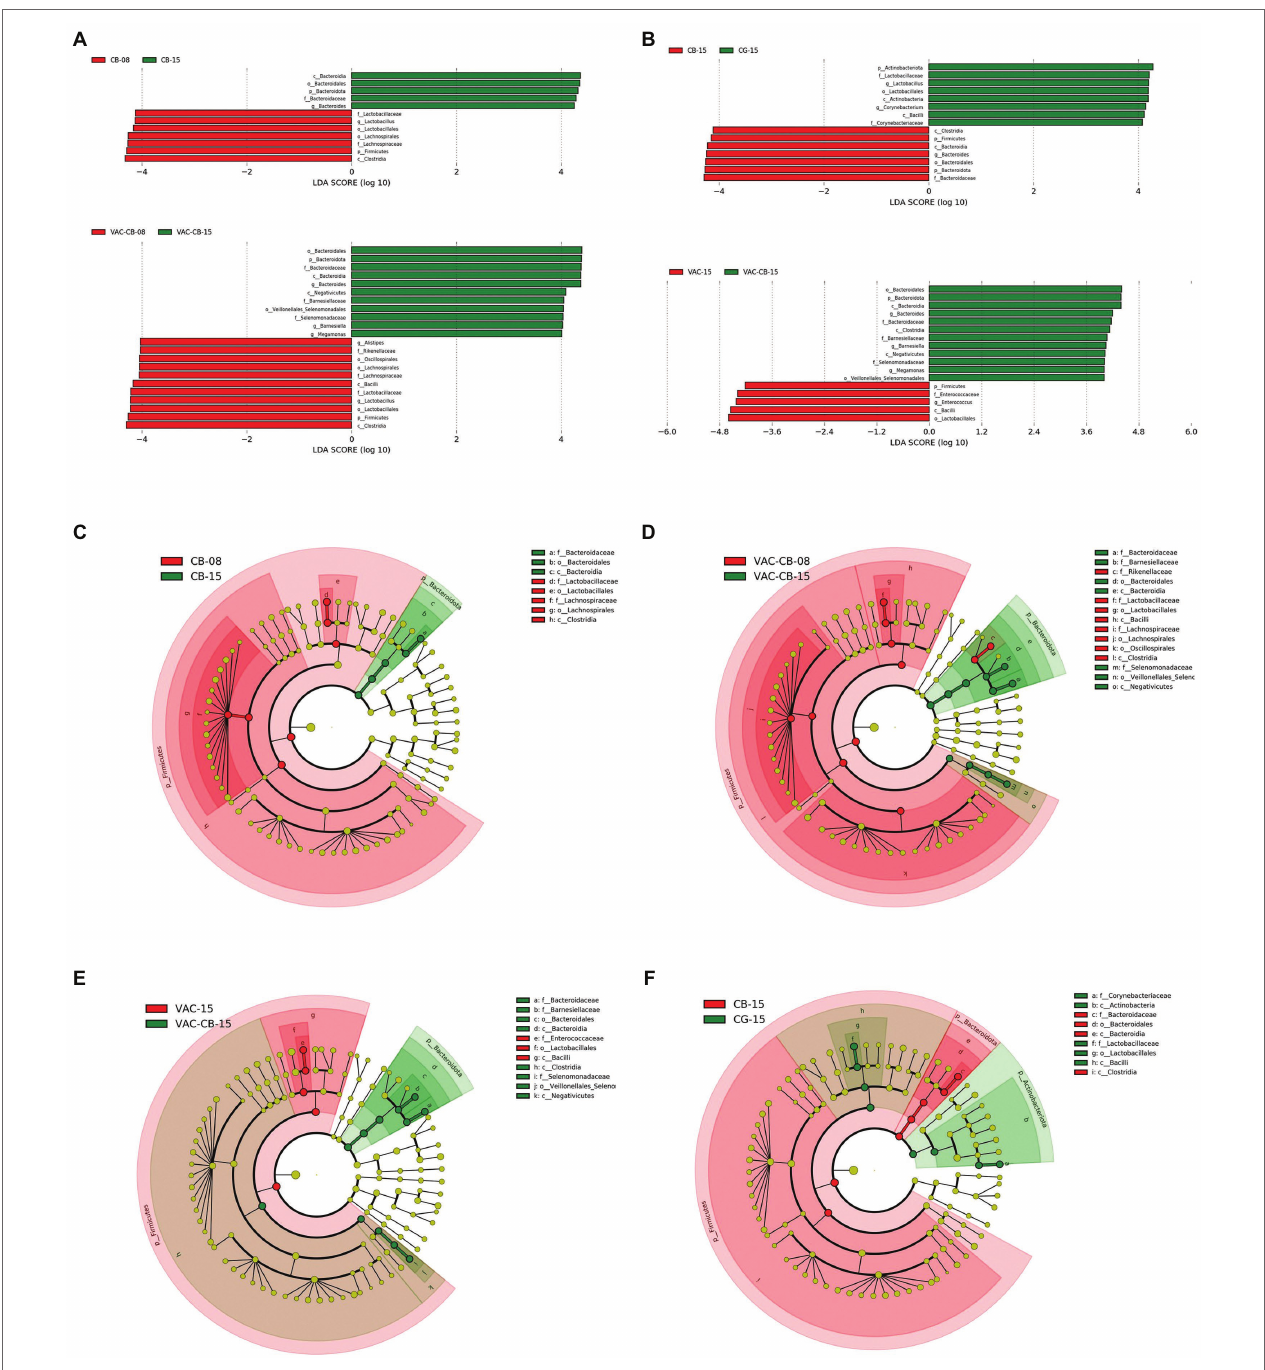
FIGURE 6 | Linear discriminant analysis (LDA) effect size (LEfSe) for the intestine microbiome from various pretreatment groups at 8 and 15 days old. (A,B) Horizontal bars represent the effect size for each taxon. The length of the bar represents the log 10-transformed LDA score, indicated by vertical dotted lines. (C–F) Cladogram of the LEfSe analysis of the intestine microbiota among different groups. The threshold for the logarithmic LDA score was 4 and p < 0.05 for the factorial Kruskal–Wallis test among bacterial taxonomic units. The taxon level was abbreviated as p, phylum; c, class; o, order; f, family, and g,